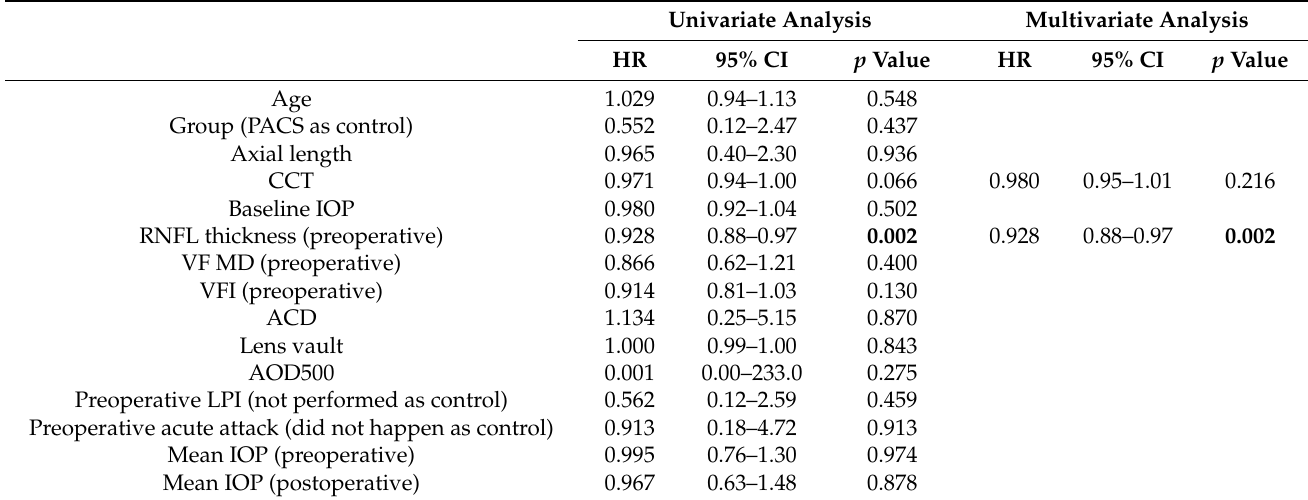
Table 4. Cox proportional hazards model to determine clinical variables associated with structure progression in primary angle closure suspect and primary angle closure.